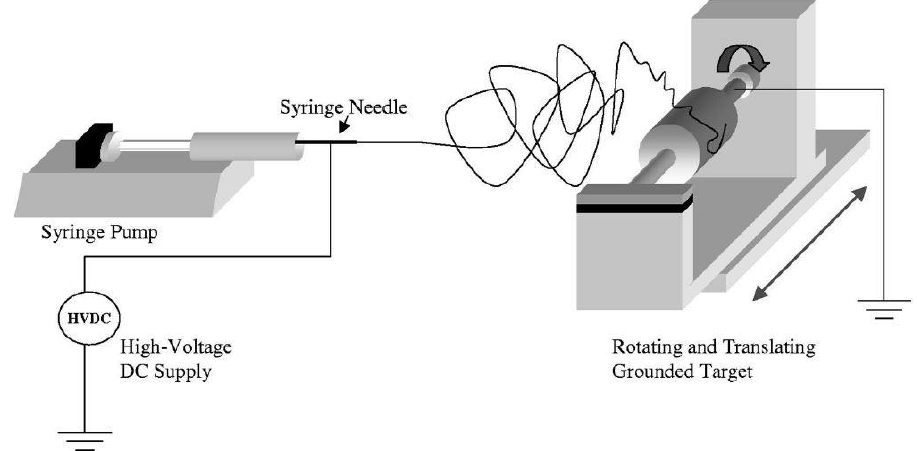
Figure 3. A schematic of the electrospinning process of polymer nanofibers